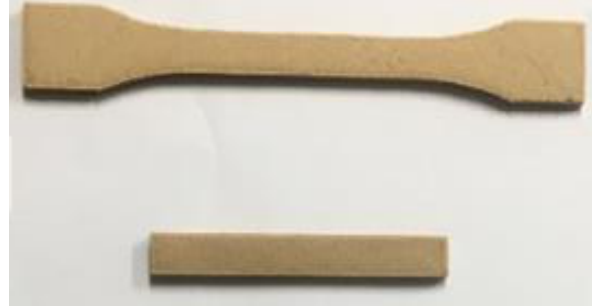
Figure 2. The printed ARP/PLA samples.